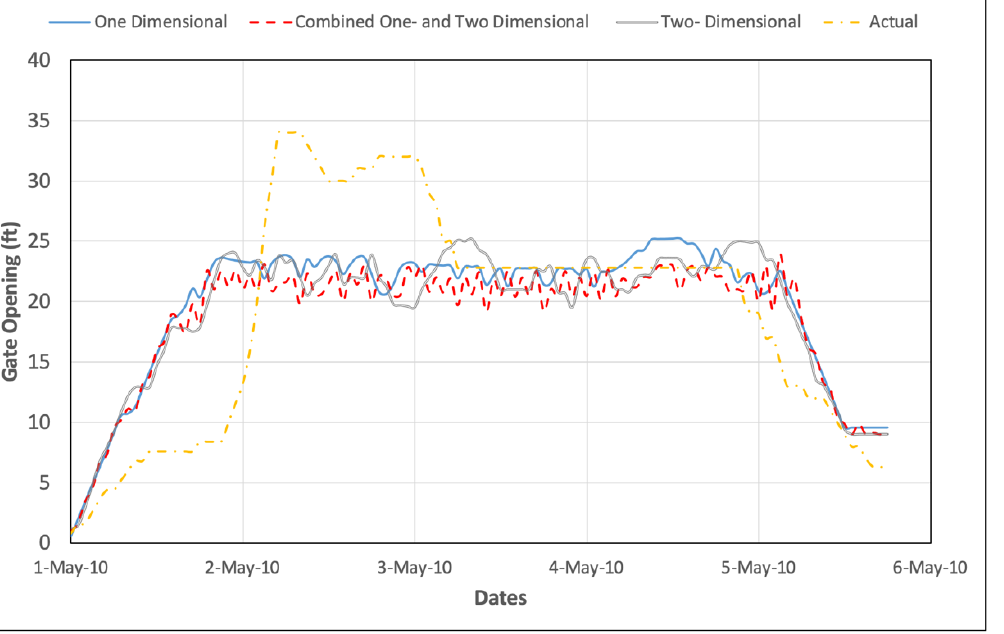
Figure 14. Optimized and actual operations (flood gate openings) of the Old Hickory Dam during the May 2010 flooding event. the May 2010 flooding